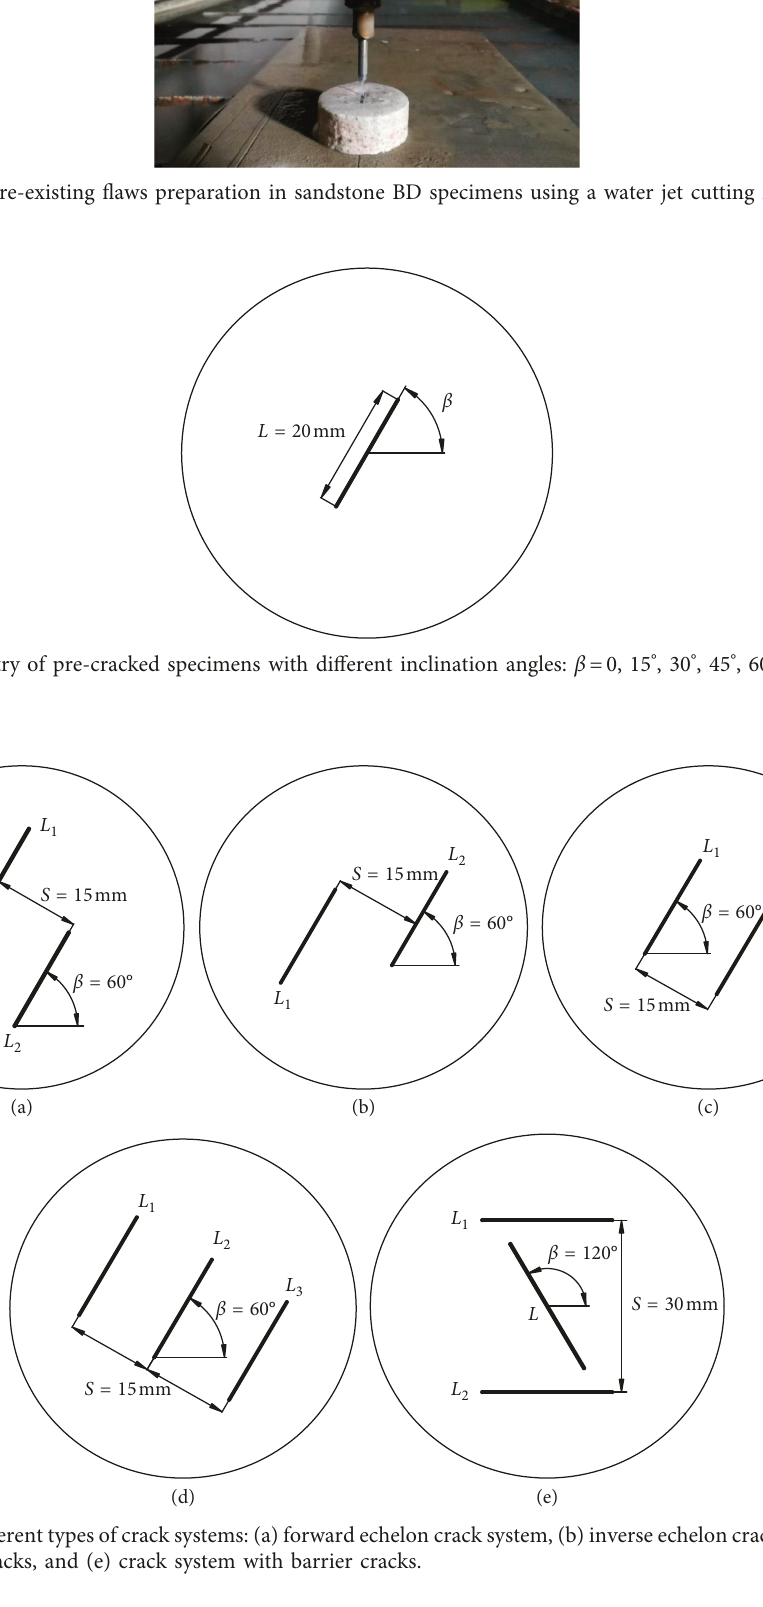
Figure 6: Geometries of different types of crack systems: (a) forward echelon crack system, (b) inverse echelon crack system, (c) two parallel cracks, (d) three parallel cracks, and (e) crack system with barrier